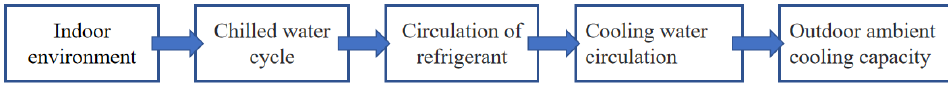
Figure 2. Cold transfer diagram.